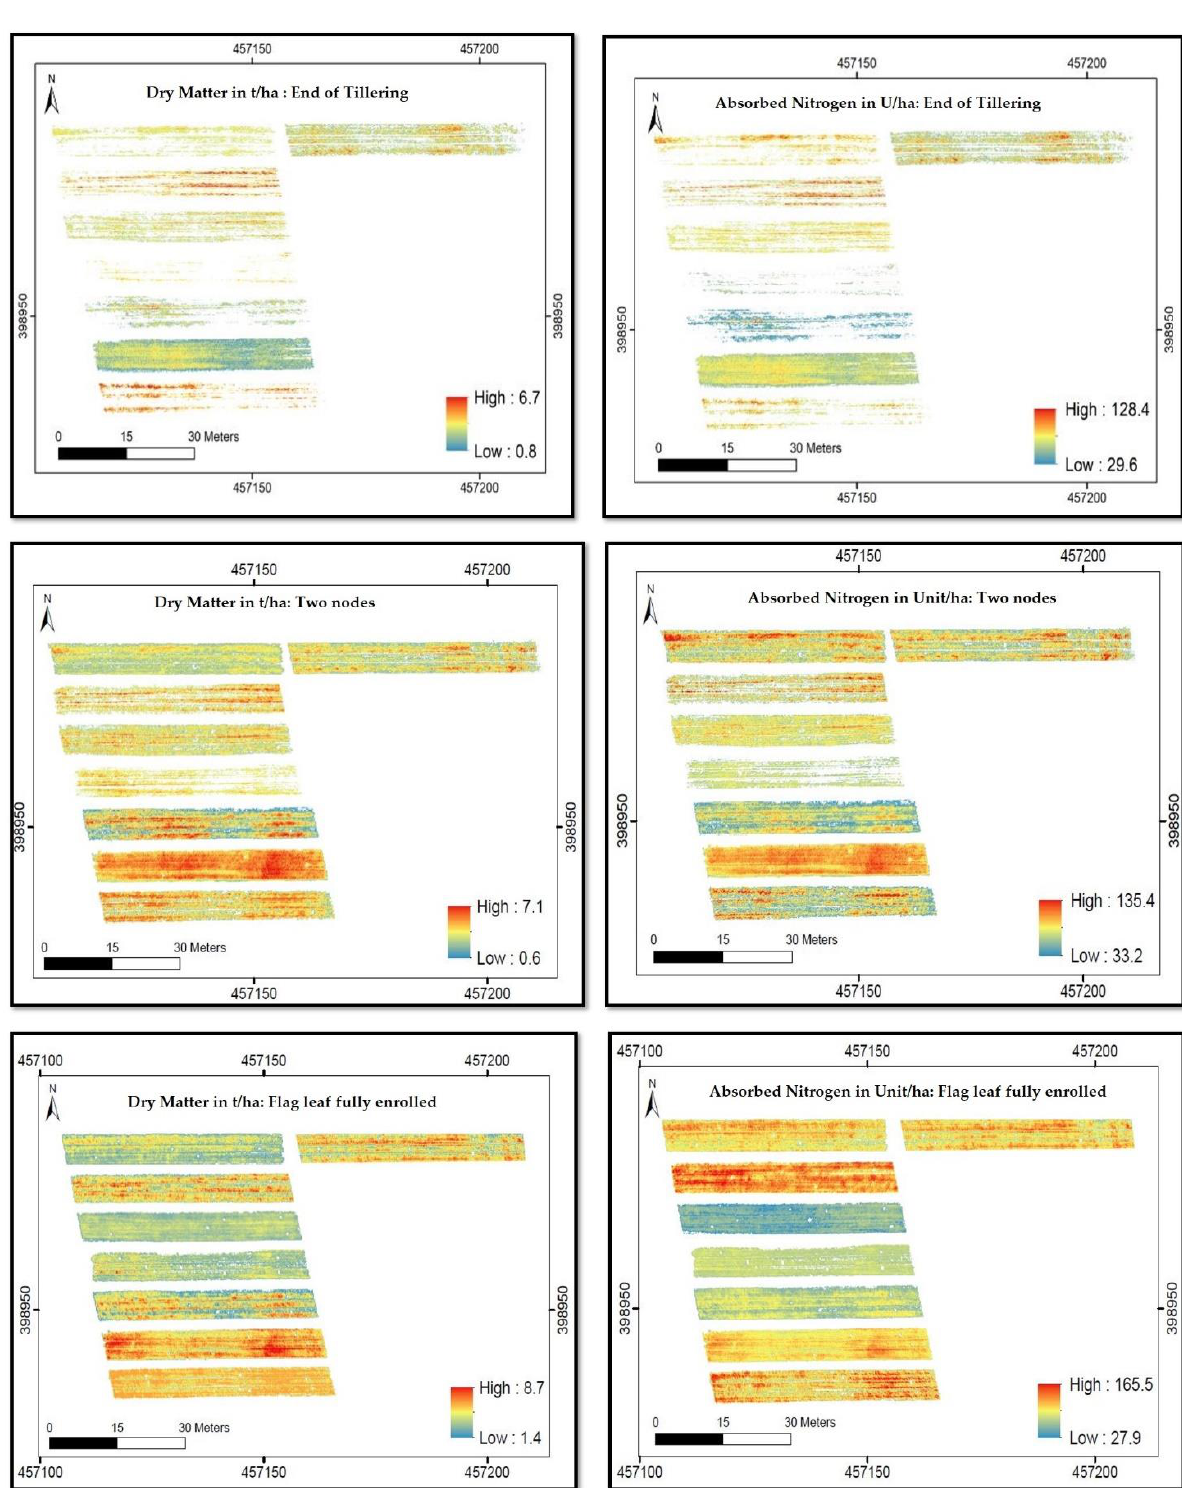
Figure 11. Dry matter and nitrogen uptake using varietal approach during end of tillering, two nodes and flag leaf fully enrolled stages.